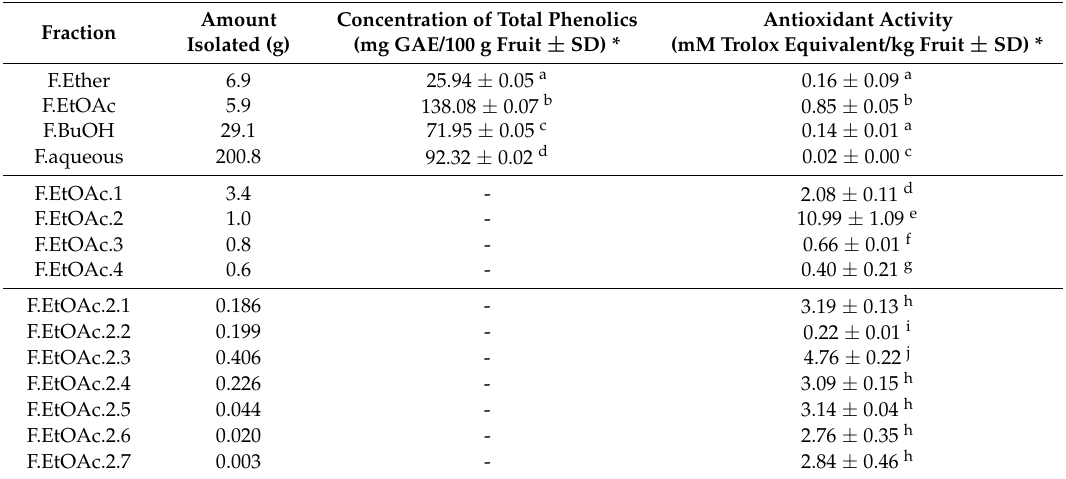
Table 1. Total phenolic content and antioxidant activity of P. friedrichsthalianum fractions.